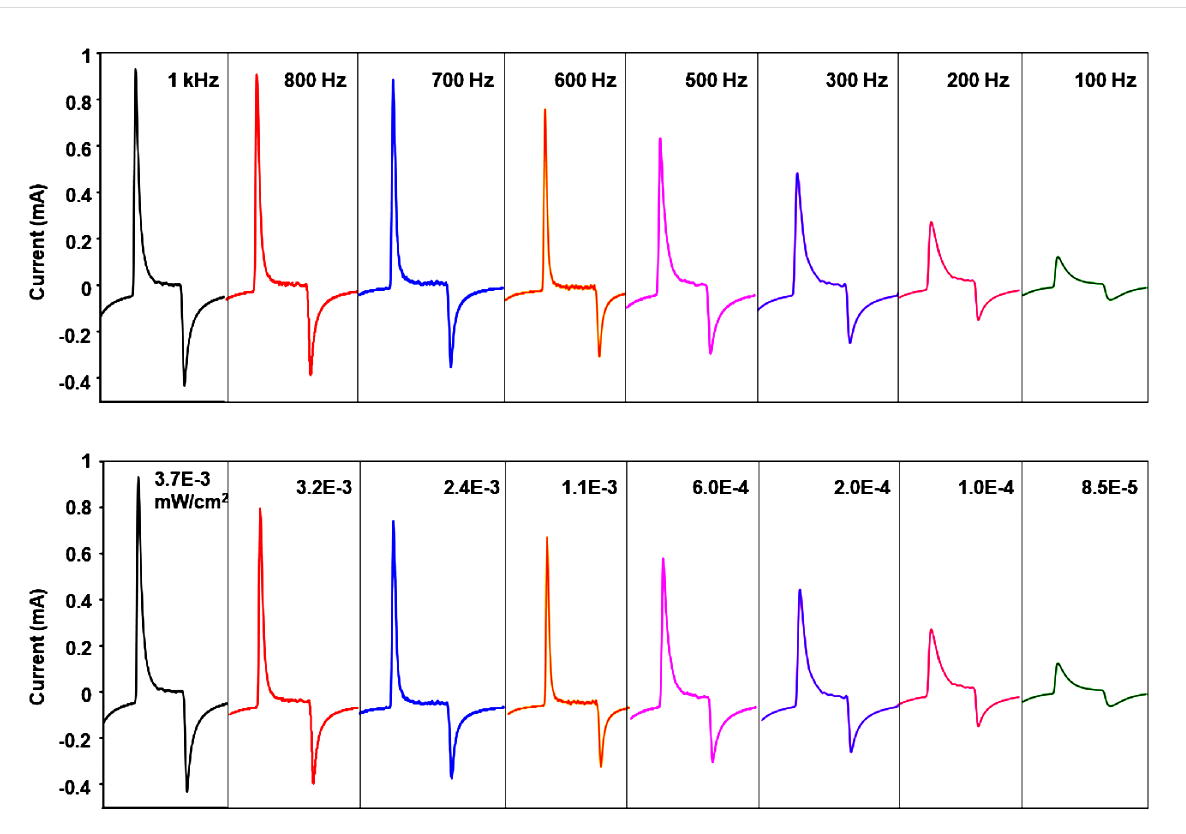
Figure 3: Impact of the incident optical power density and periodic frequency on the short-circuit current. I–t characteristics of a PD under zero bias and 325 nm UV illumination with different periodic frequencies ranges from 100 Hz to 1 kHz (top row). I–t characteristics of a PD under zero bias and 325 nm UV illumination with different power densities ranges from 8.5 × 10 − 5 to 3.7 × 10 − 3 mW/cm 2 (bottom row).